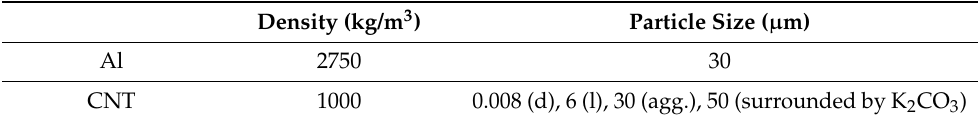
Table 4. Density and viscosity of solvent (DMAs) and dispersant (K 2 CO 3 ). Table 3. Density and particle size of Al and CNT.